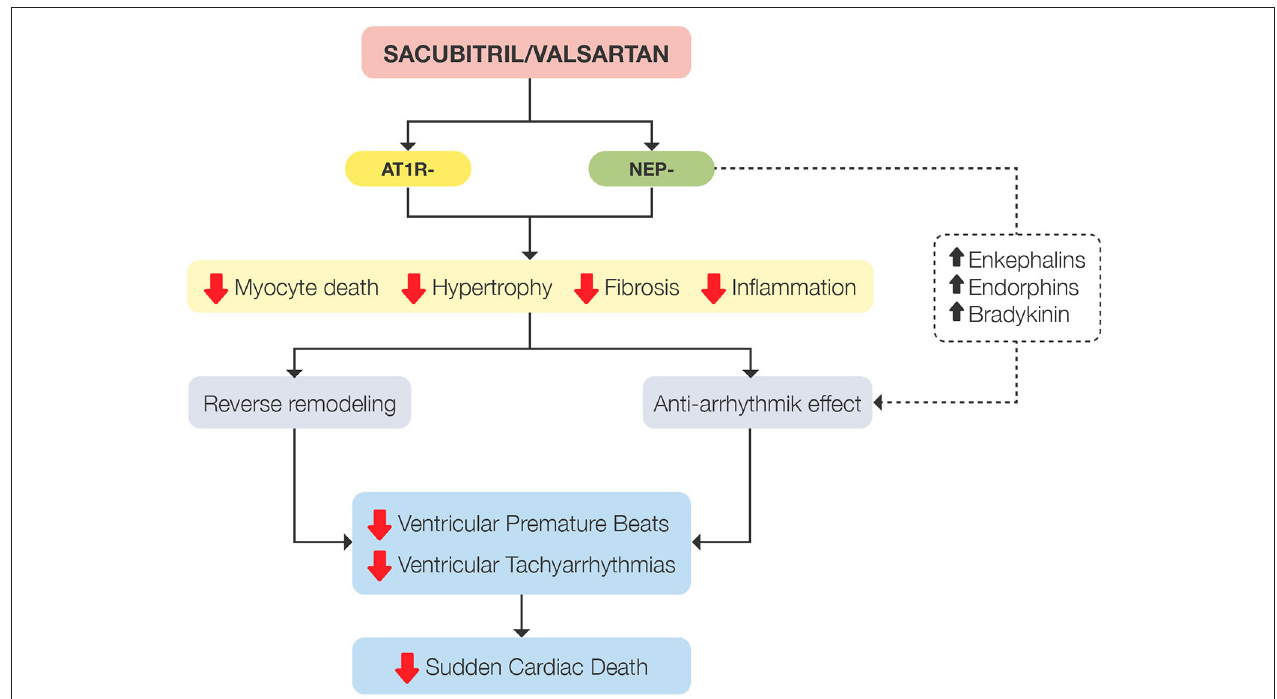
FIGURE 1 | Summary of mechanisms involved in reducing the sudden death rate demonstrated by sacubitril/valsartan. AT1R-, angiotensin type 1 receptor inhibition; NEP-, neprilysin inhibition.